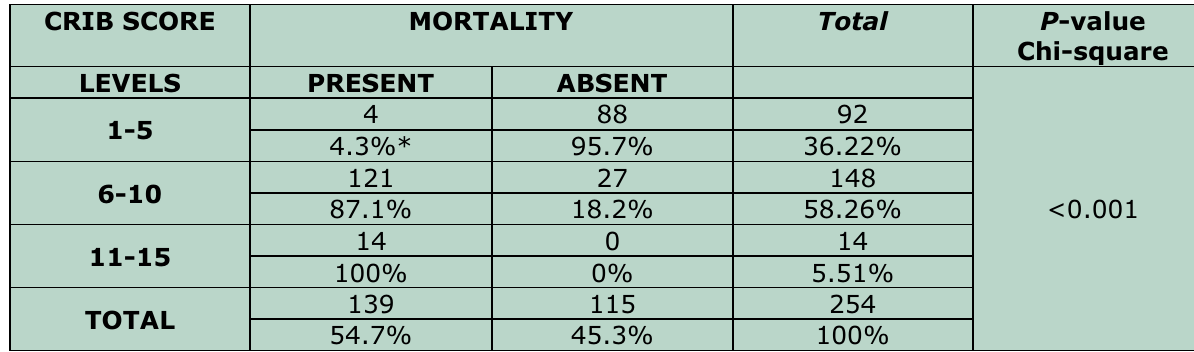
Table-V: P  ercentage mortality in different levels of CRIB